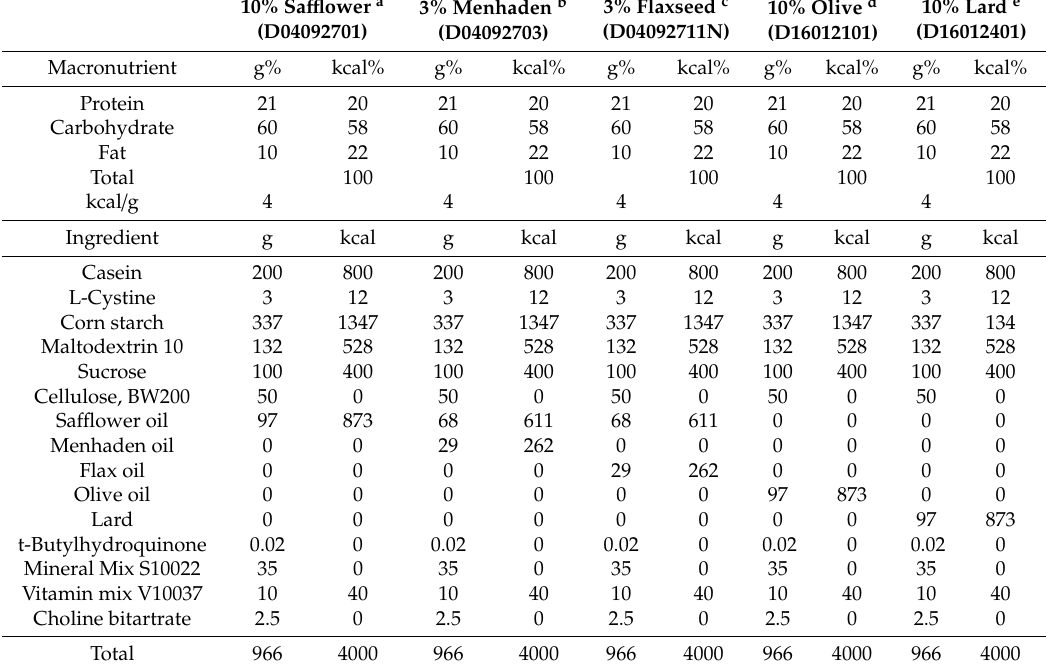
Table A1. Composition of modified AIN-93 G rodent diets (research